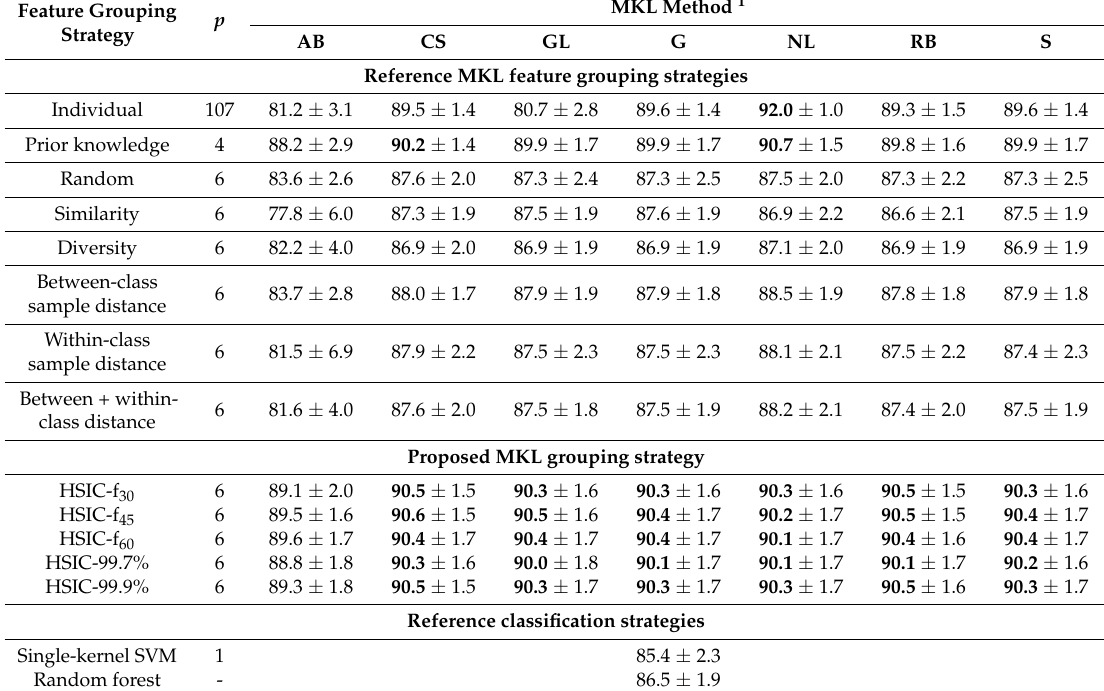
Table 5. Overall accuracy (averaged over the 10 folds) using various feature grouping and kernel weighting strategies. p indicates the number of feature groups form which the K m input kernels are obtained. All combinations resulting in an OA above 90% are marked in bold. “HSIC grouping” refers to the proposed feature grouping